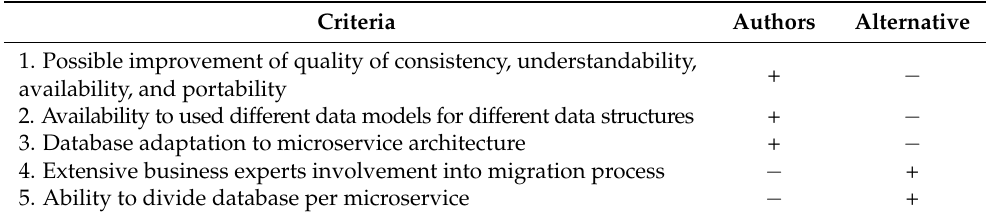
Table 4. The results of the comparison of the authors’ proposed monolith database migration approach and the technique proposed by A. Levcovitz et